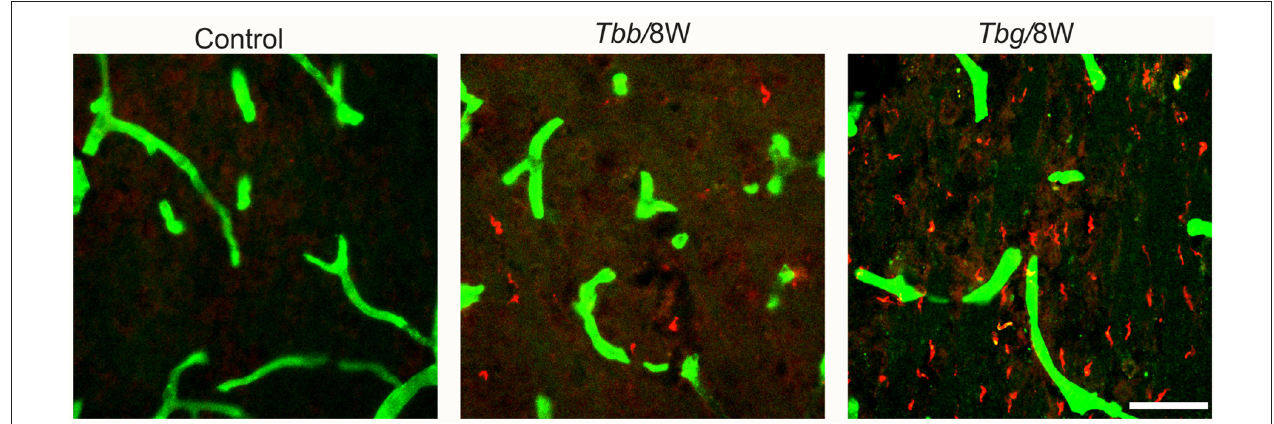
FIGURE 1 | Confocal microscopy images showing parasites (in red) in the brain parenchyma at 8 weeks (W) after Trypanosoma brucei brucei ( Tbb ) or Trypanosoma brucei gambiense ( Tbg ) systemic infection. Blood vessel walls are visualized by anti-glucose transporter-1 immunolabeling (in green). Scale bar: 40 µ m.